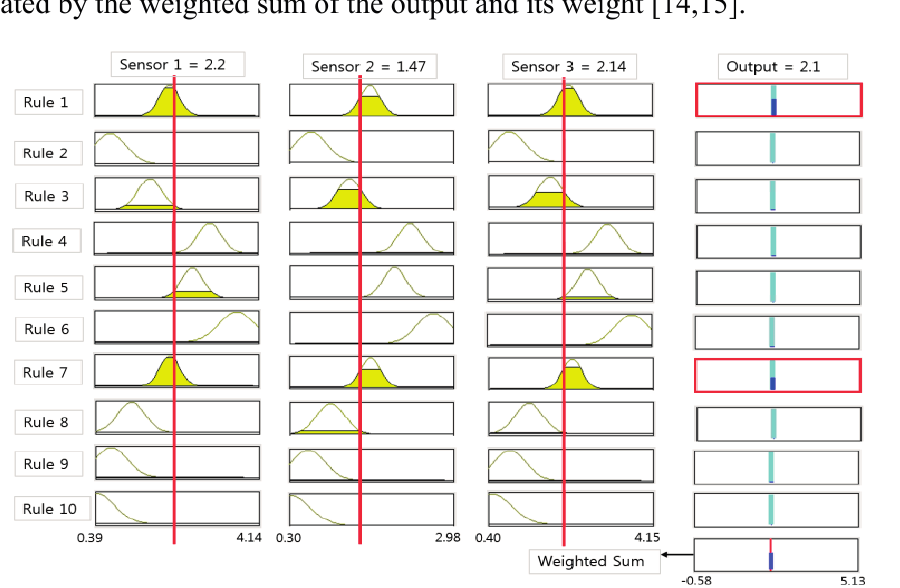
Figure 10. Fuzzy rule and inference value for density